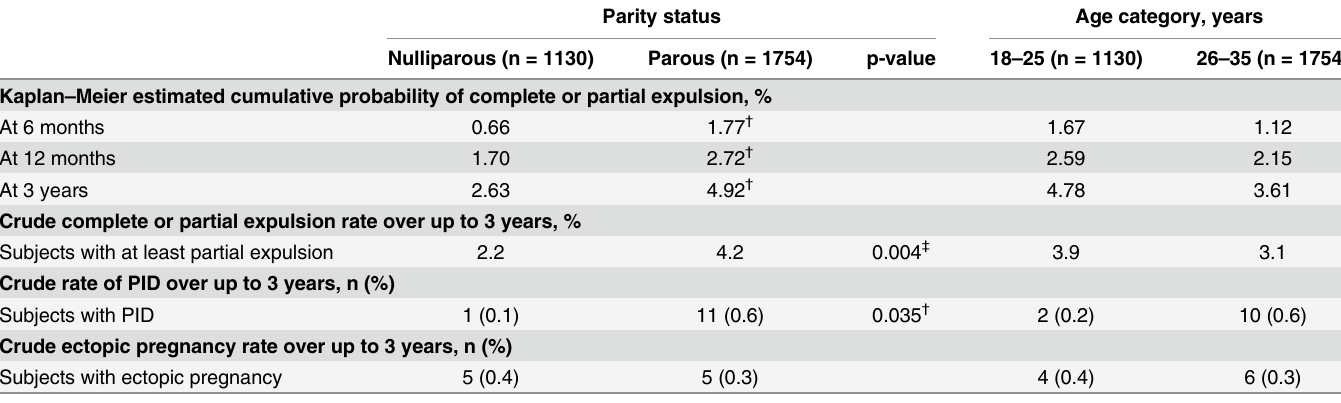
Table 5. Adverse Events (Both Treatment Groups Combined) According to Parity and Age (Full Analysis